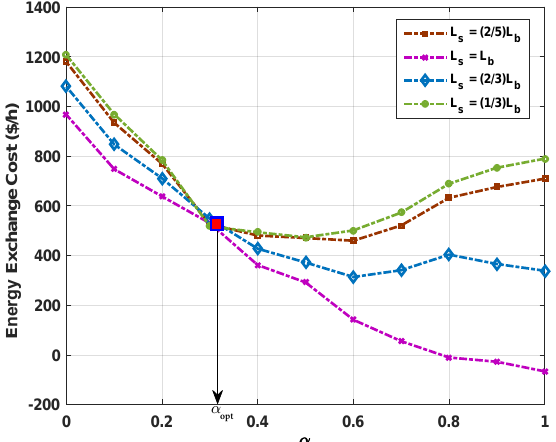
Figure 9. Impact of different export prices on the annual energy exchange cost, C ex , α . Note that these results have been plotted for Location C. The point of intersection gives α opt